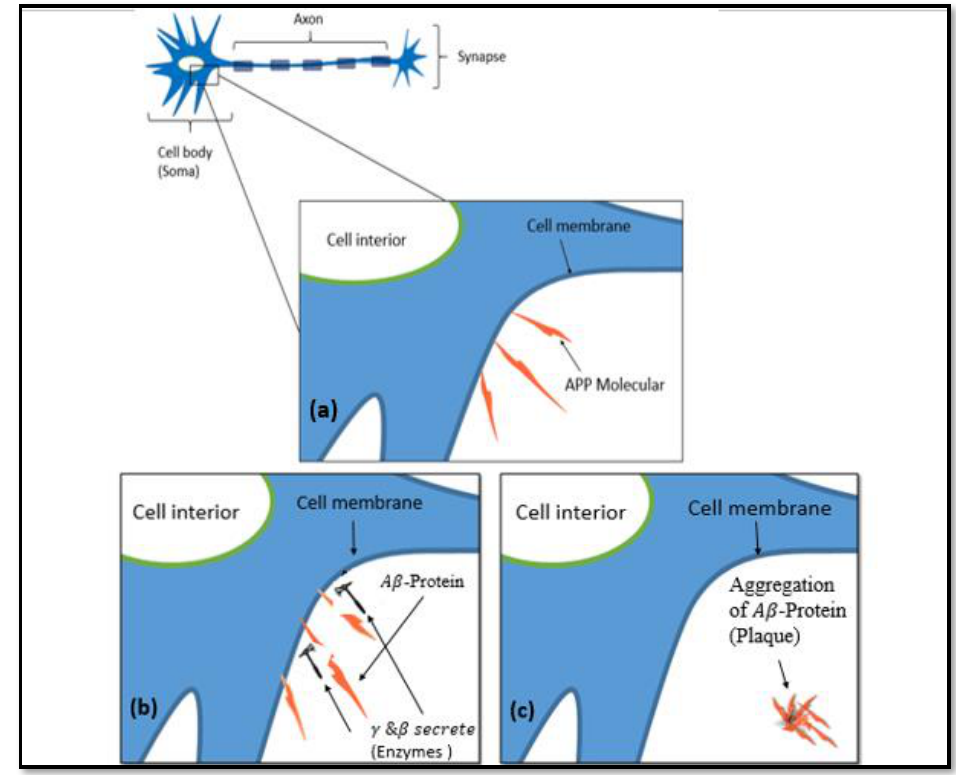
Figure 1. ( a ) Amyloid precursor protein (APP) is a primary membrane protein that is part of the cell membrane; ( b ) the cleaving of APP by incident enzymes; and ( c ) the aggregation of amyloid-beta (A β ) to form a plaque.